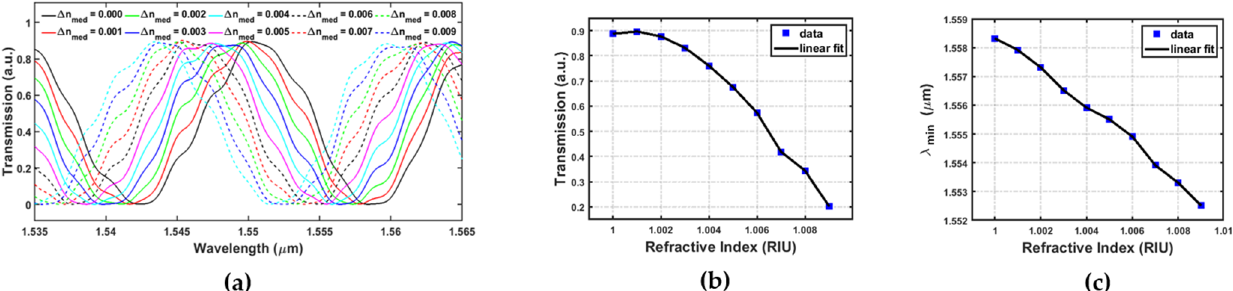
Figure 4. ( a ) The output transmission spectra of the LT-MZI sensor with a length L of 50 µm at different refractive indices ranging from 1.000 to 1.009; ( b ) LT-MZI sensor transmission versus the medium’s refractive index around λ = 1.55 µm with L = 50 µm; ( c ) LT-MZI sensor minimum wavelength versus the medium refractive index with L = 50 µm.